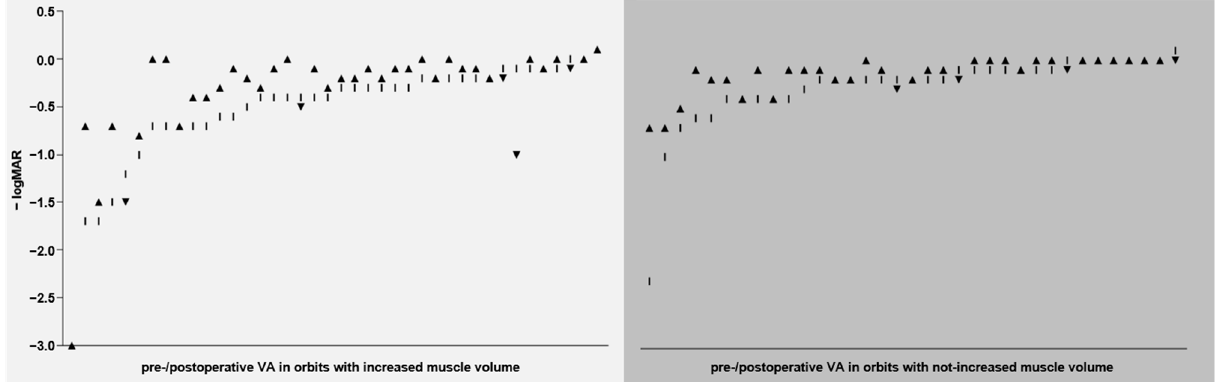
Figure 5. Development of visual acuity after orbital decompression. − logMAR, negative logarithm of the mean angle of resolution; VA, visual acuity; y axis, VA values per orbit before and after orbital decompression (given as negative logMAR, which means that the more negative the value, the worse the visual acuity); x axis, pre-/postoperative VA values of each orbit in the group with increased orbital muscle volume (left, light gray background) and in the group with not-increased orbital muscle volume (right, medium gray background); vertical line, preoperative VA value per orbit; black triangle (sharp angle upwards), postoperatively improved (or stable) VA value per orbit; black triangle (sharp angle downwards), postoperatively deteriorated VA value per orbit.